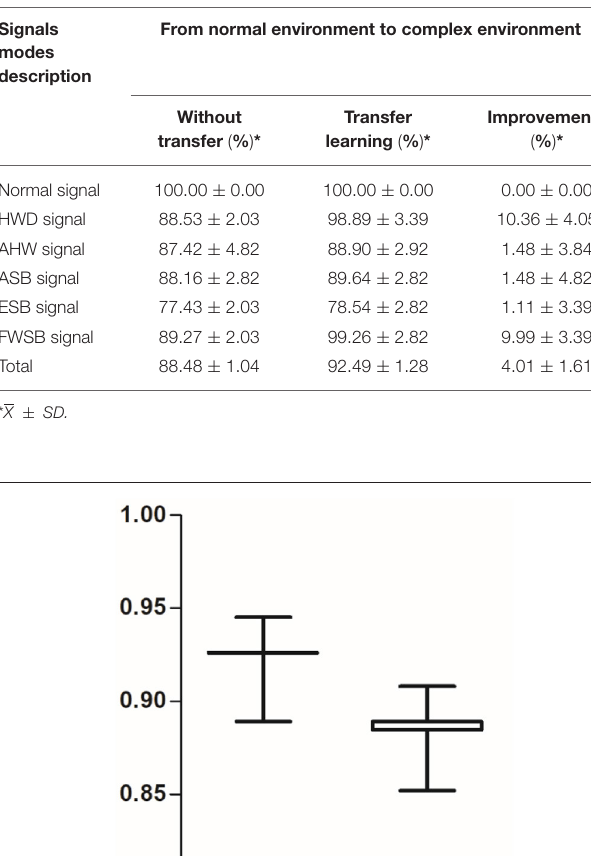
value of polynomial kernel is 2) (Hu et al., 2005), KNN (Yang et al., 2016b), and RF (Mohapatra et al., 2020). All the experiments repeated 30 times, respectively, and all the results are presented in Table 4 . The novel method had a higher accuracy than the traditional ML methods in a complex environment.